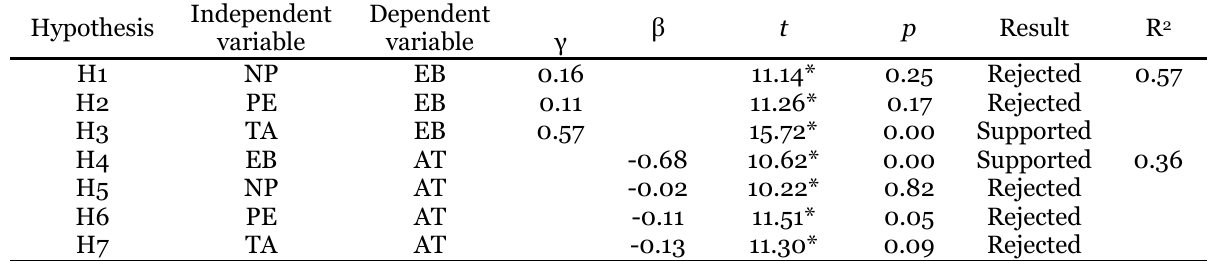
Structural Model Test for